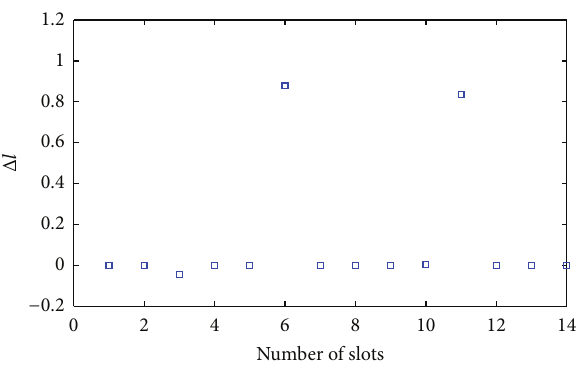
Figure 5: The difference between exact and estimated excitations (simulations) with failures at positions 𝑛 = 6 and 𝑛 = 11 : 𝑆 = 2 , 𝑀 = 11 , and MSE = 25 dB.